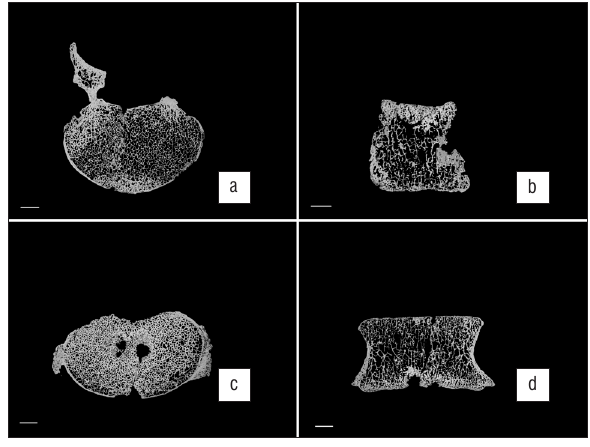
Figure 4: Micro-CT orthoslice views of the L4 vertebra of StW 431: (a) transverse superior, (b) sagittal midline, (c) transverse inferior and (d) anterior. Note the bilateral osteophytic formation and two zones of erosion evident on the inferior endplate surface of the L4 in (c). There is no evidence of sclerosis or new bone formation around the margins of the cavities (c). Also note areas of new bone formation ranging from open woven (c) to sclerotic